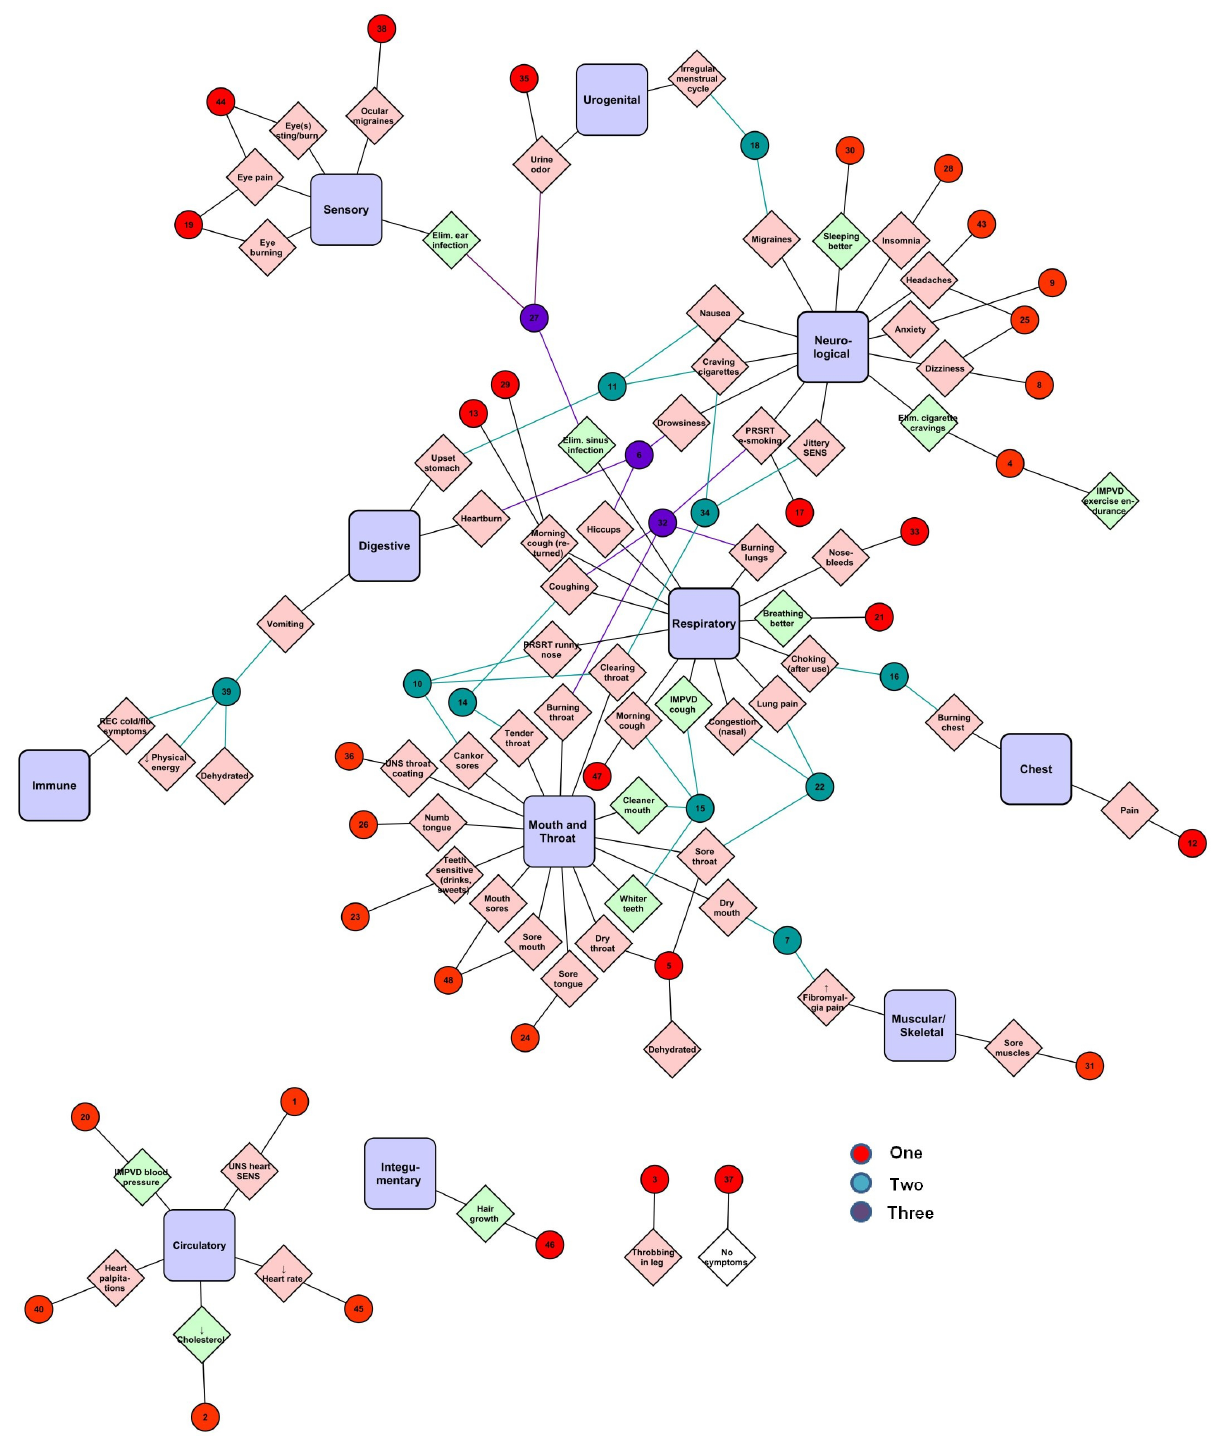
Figure 6. Interactome for Vapor